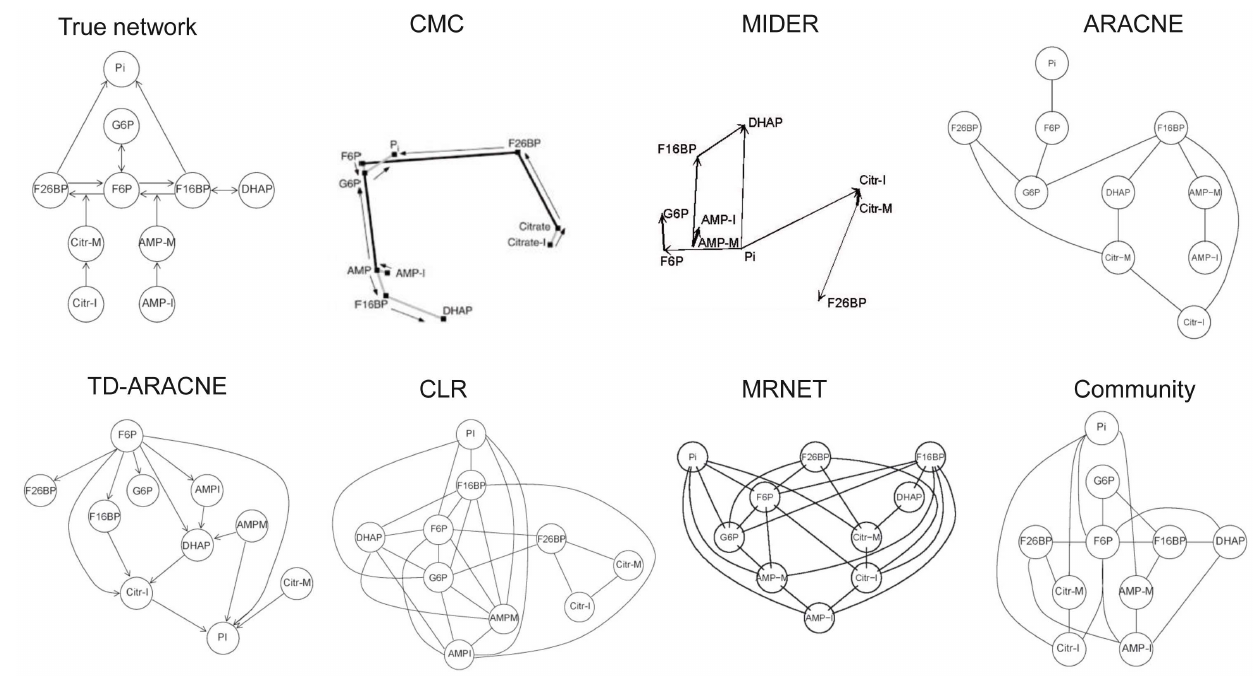
Figure 5. Benchmark B1. First reaction steps of glycolysis.